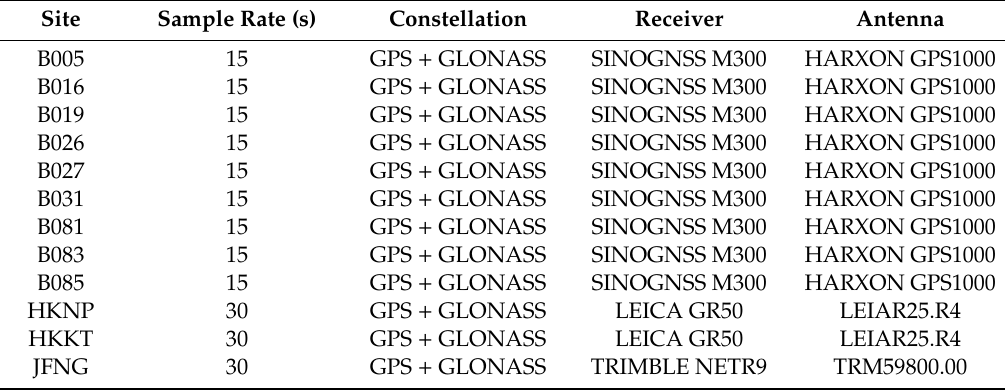
Figure 2. Global distribution of 24 validation stations: ( a ) distribution of 12 GNSS stations in China and ( b ) distribution of 12 IGS GNSS stations across the world. Table 4. Sample rate, constellation, receiver, and antenna of validation stations.